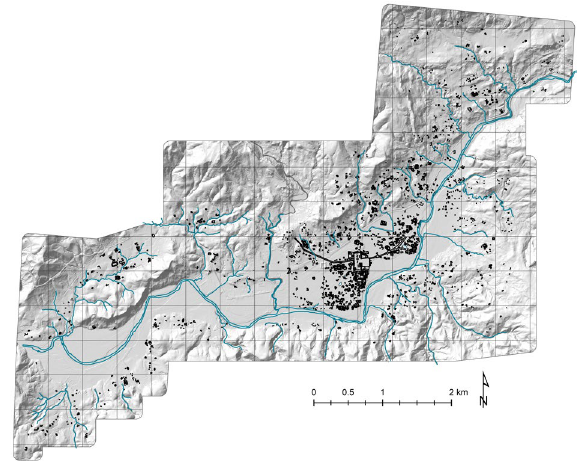
Figure 1 . Copan ALS survey area illustrating archaeological sites on LIDAR-derived Digital Elevation Model